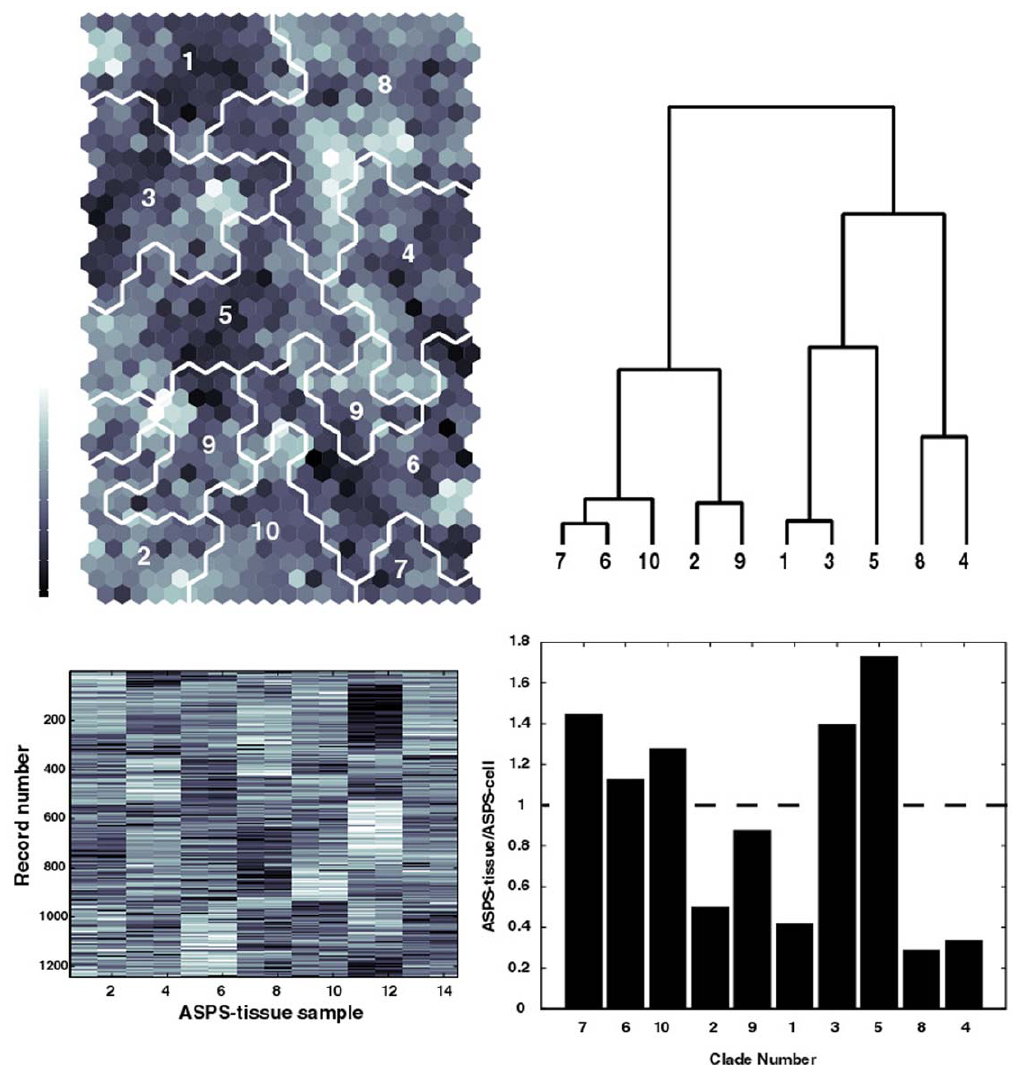
Figure 5. Top left panel displays the SOM for the 1244 individual patient gene expressions from ASPS-tissue and ASPS-1 (1244 genes). SOM colors indicate the similarity of gene measurements between SOM clusters (dark: similar light:less similar). Dendrogram (clipped at 10 SOM meta-clades) from hierarchical clustering of SOM codebook vectors is displayed in the upper right panel. Corresponding SOM meta-clades are identified on the SOM by the white boundary lines. Matching labels appear on the SOM regions and SOM dendrogram. Lower left panel displays the gene expression measurements for the 1244 ASPS-tissue genes for 7 patients, done in replicate. Records are ordered from top to bottom from the left to right meta-clades of the dendrogram. Record boundaries are: SOM meta-clade 7; rows 1–41, SOM meta-clade 6; rows 42–256, SOM meta-clade 10; rows 257–340, SOM meta-clade 2; rows 341–425, SOM meta-clade 9; rows 426–526, SOM meta-clade 1; rows 527–646), SOM meta-clade 3; rows 647– 787, SOM meta-clade 5; rows 788–934, SOM meta-clade 8; rows 935–1143, SOM meta-clade 4; rows 1144–1244, Lower right panel displays the histogram for the ratio of counts of genes in the ASPS-tissue set to counts of genes in the ASPS-1 set. Dashed horizontal line defines cases where equal fractions of ASPS-tissue and ASPS-cell genes occur in a meta-clade. Here SOM meta-clades (7, 6, 10, 3 and 5) represent ASPS-tissue genes greater in abundance than found for ASPS-1 genes.